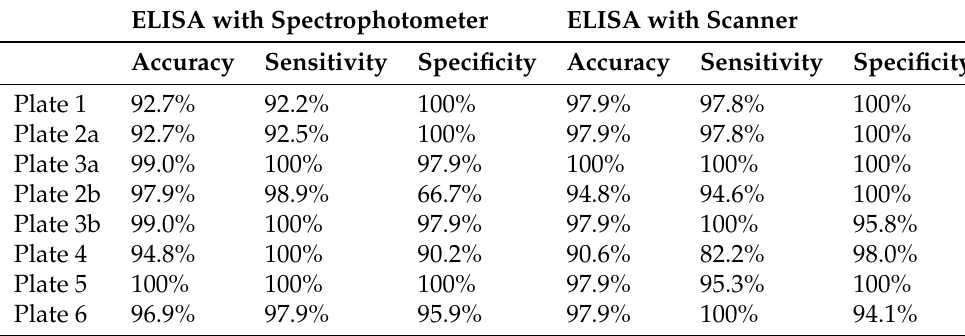
Table 3. Comparative results with a spectrophotometer for a set of plates.